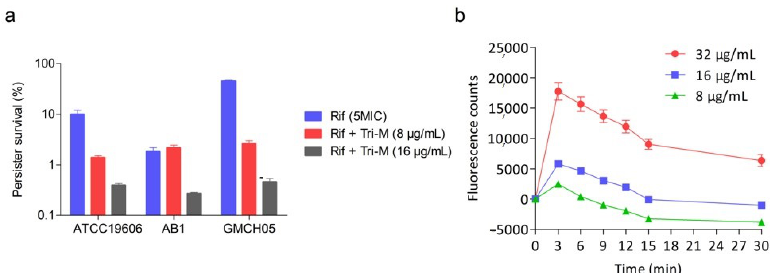
Figure 6. Effect of combination therapy on persisters’ survival. ( a ) The survival of bacterial persisters after 4 h treatment with rifampicin or tridecaptin M alone and in combination. The persisters were confirmed by determining the minimum inhibitory concentration (MIC) of two representatives after subculturing on a fresh agar plate containing no antibiotics. The MIC values were similar, indicating that persisters were not resistant to antibiotics. ( b ) NPN assay with stationary-phase bacteria indicating the permeabilization of persisters with tridecaptin M at different concentrations. Data plotted are mean values of three replicates. Bars denote the standard deviation.